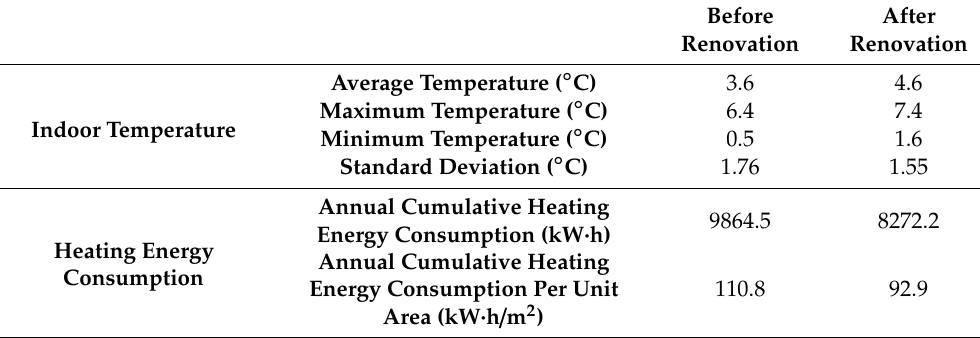
Figure 19. The annual cumulative heating energy consumption before and after renovation of exterior walls. Table 7. The data of temperature and energy consumption before and after renovation of exterior walls.